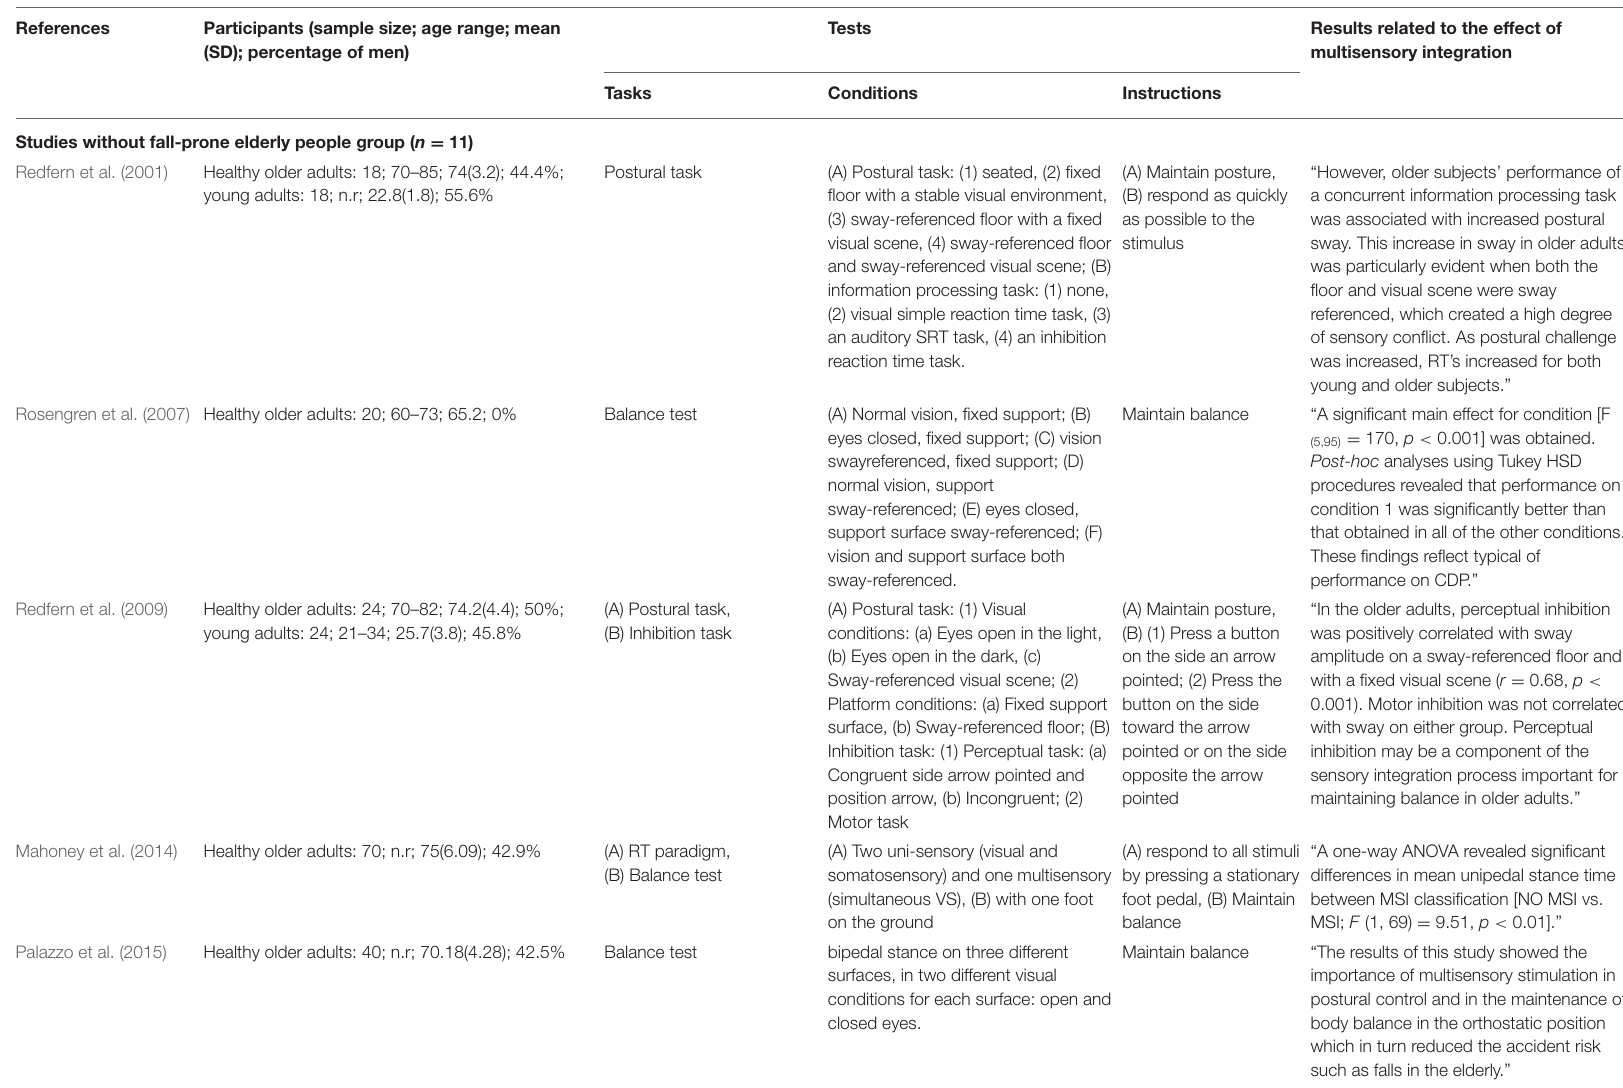
Balance test bipedal stance on three different surfaces, in two different visual conditions for each surface: open and closed